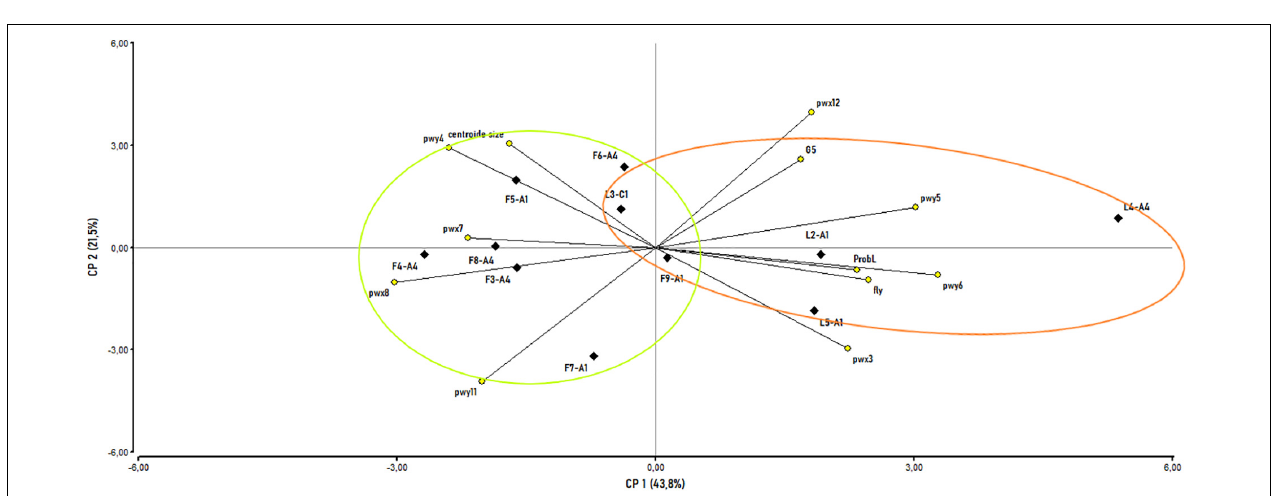
FIGURE 7 | Principal components analysis (PCA) scatterplot for colonies based on morphometric and behavioral variables. Morphological measurements included: ProbL, G5, centroid size, pwx3, pwy4, pwy5, pwy6, pwx7, pwx8, pwy11, and pwx12. Behavioral measurements included: “fly.” Mitochondrial haplotypes are: A1, A4, and C1. The colonies were named according to the apiary they belong (L: LE and F: FAM) followed by the number of colony – Haplotype, according to the information described in Supplementary Table 1 . Ellipses show colonies from the same apiary. Green ellipse: FAM; yellow ellipse: